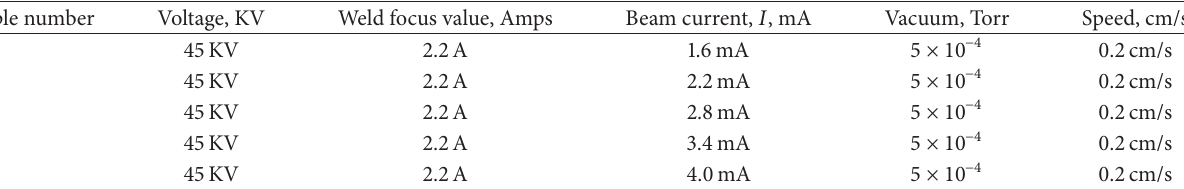
Table 3: The parameters for electron beam welding process.